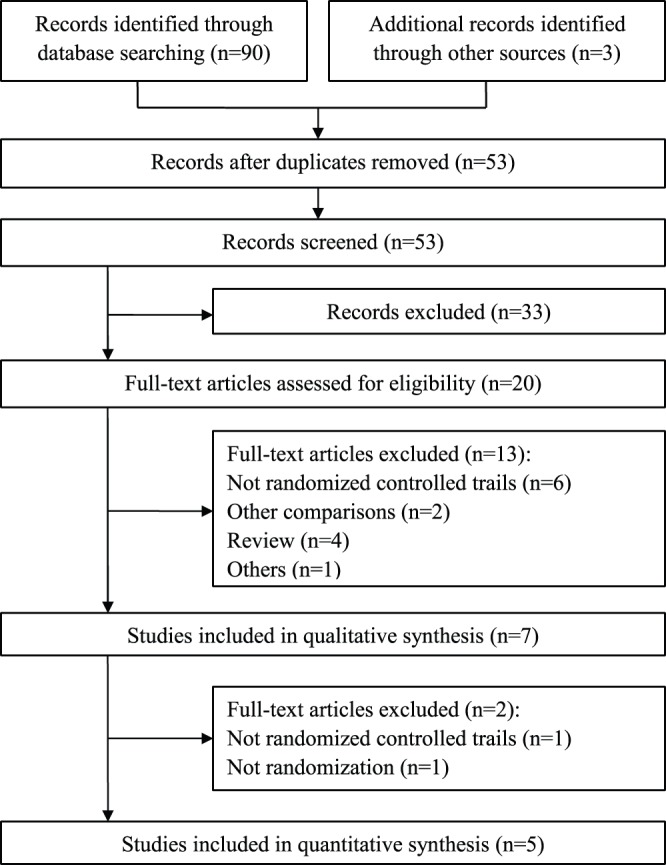
PRISMA flow diagram.